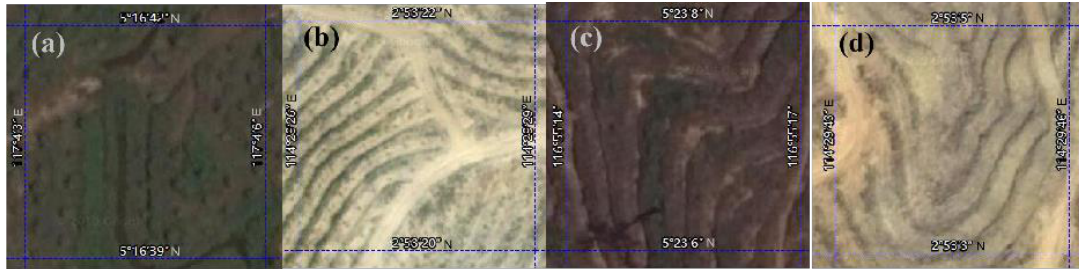
Figure 4. High-definition images with similar characteristics: ( a,b ) oil palm ground; ( c ) woodland; and ( d ) bare